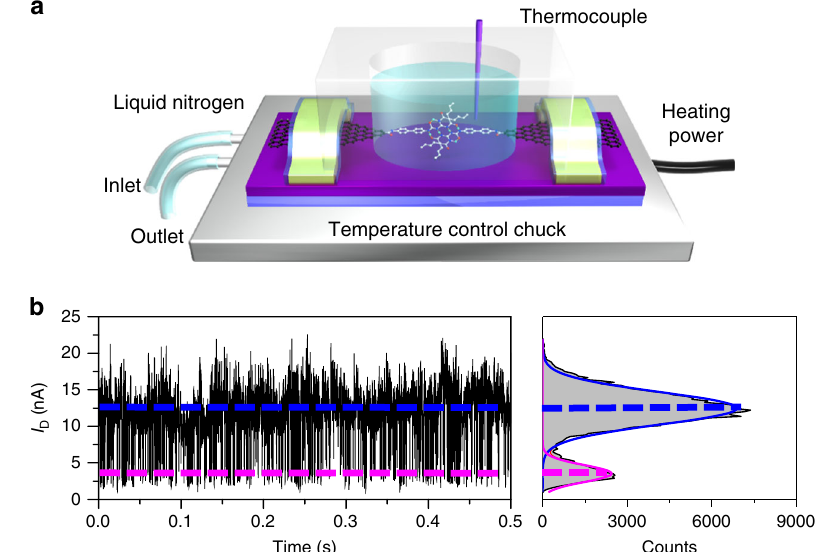
Fig. 2 Measurement setup and real-time current recordings of hydrogen bond dynamics. a Schematic illustration of the electrical measurement setup. b Real-time current recordings of hydrogen bond dynamics during 500 ms measured in TeCA at 273 K. The right panel is the corresponding histogram of current values, showing a bimodal current distribution. V bias = 300